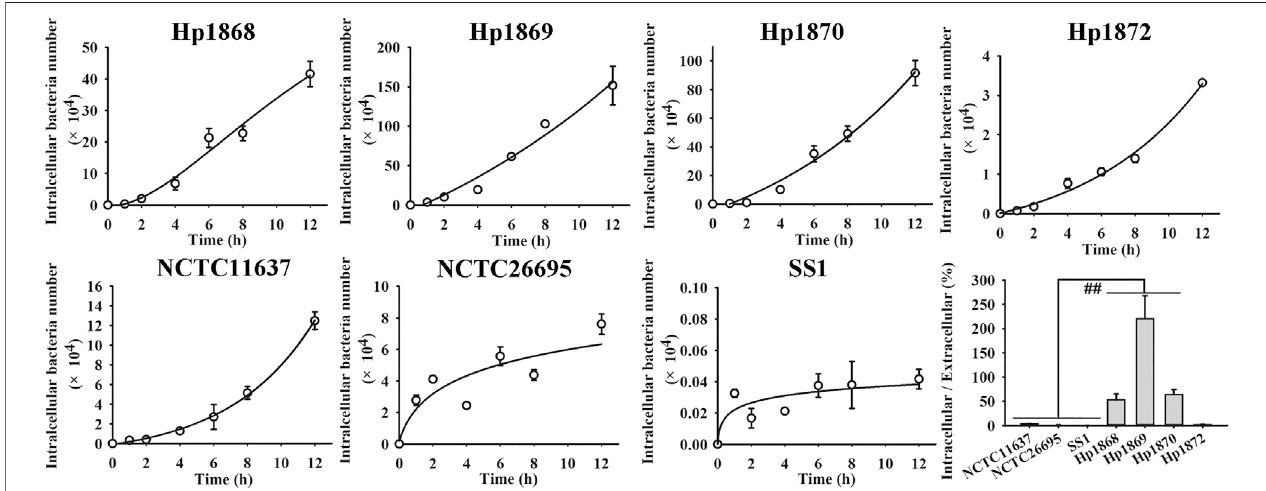
FIGURE2| Time-dependentinvasionofdifferent H.pylori strains.Theinvasionratesofstandardandclinical H.pylori strainsincreasedover12 h.Theinvasionrates of Hp 1868 (52.93 ± 24.23%), Hp 1869 (220.31 ± 95.68%), and Hp 1870 (63.88 ± 20.77%) were signi fi cantly higher than those of the standard strains NCTC11637 (3.46 ± 0.35%), NCTC26695 (1.24 ± 0.49%), and SS1 (0.01 ± 0.002%). ** p < 0.01, n (cid:2)